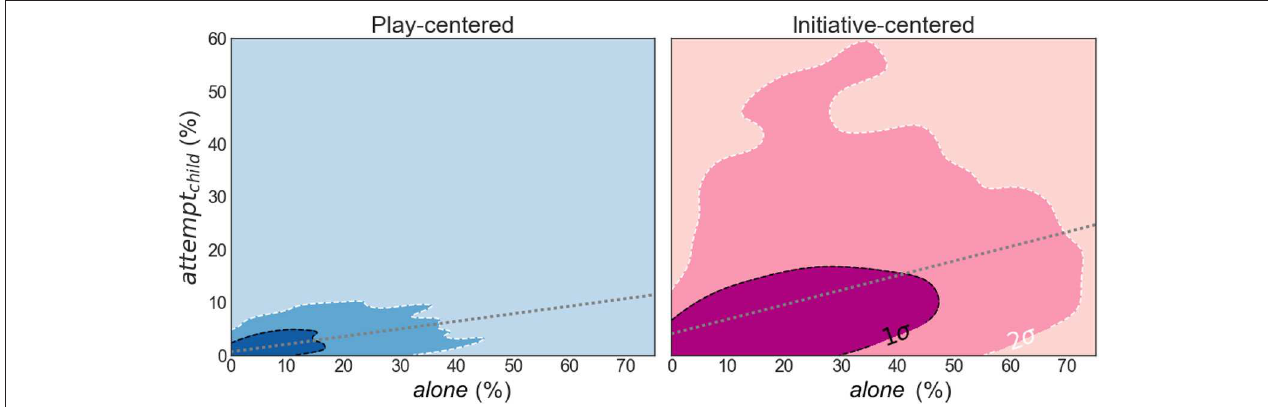
FIGURE 2 | A comparison between the two dyads with either a play-centered parent (blue, left panel) or an initiative-centered parent (pink, right panel): density plots across 2,000 simulated sessions of the time spent both playing alone (percentage of session time; horizontal axis) versus attempts to initiate play by the child ( attempt child ; percentage of session time; vertical axis). High density regions are darker than low density regions. 1- and 2- σ confidence intervals are indicated with dashed lines: 68 percent of the sessions fall within the black contours; 95 percent of the sessions fall within the white contours. Within each dyad, the more time is spent both playing alone, the more time is typically spent initiating play by the child – as we illustrate with simple linear regression (gray dotted lines; play-centered parent: attempt